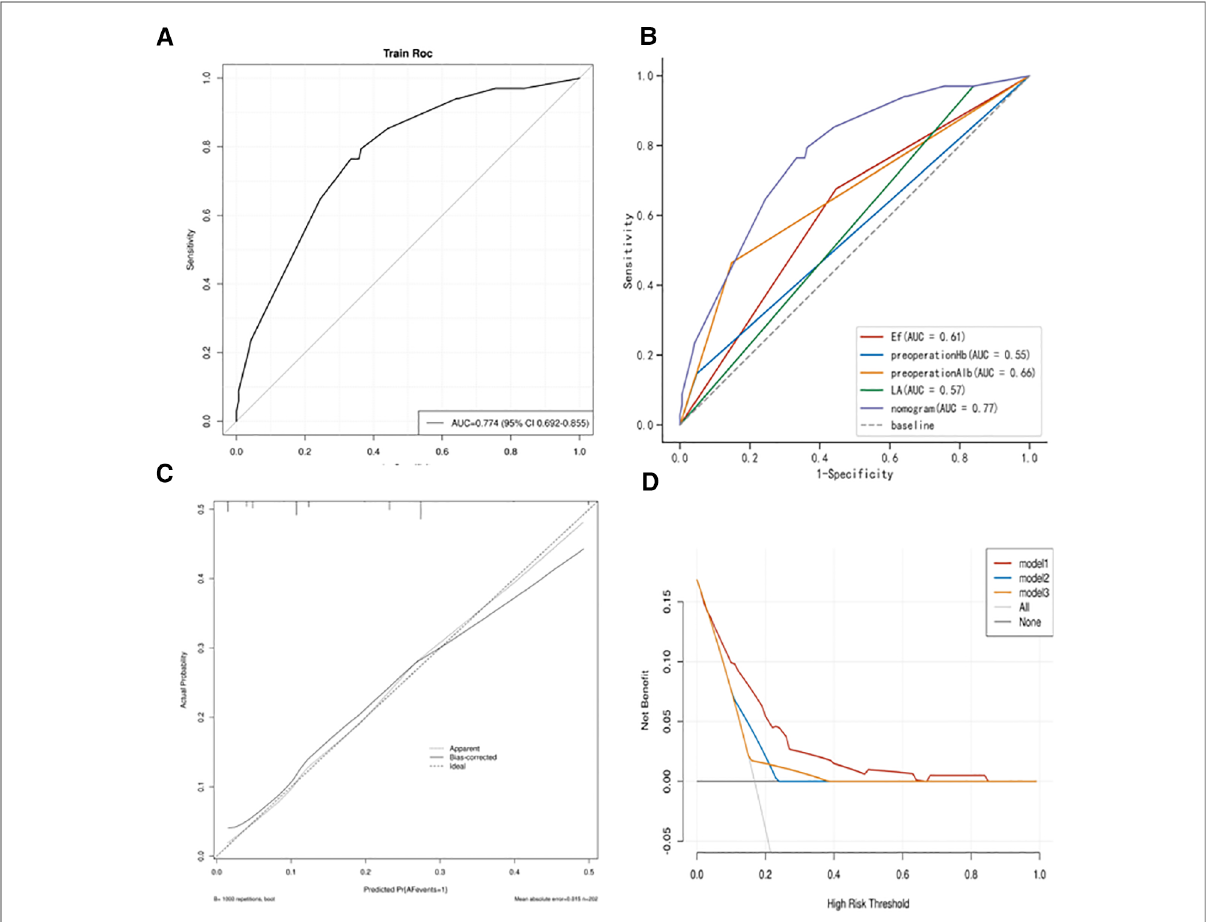
FIGURE 4 ( A )Receiveroperatingcharacteristic(ROC)curvesoftheestablishednomogrammodel;( B )ComparisonofROCcurvesbetweentheestablishednomogram modelandtheconstructedfactors;( C )Calibrationcurveoftheestablishednomogrammodel;( D